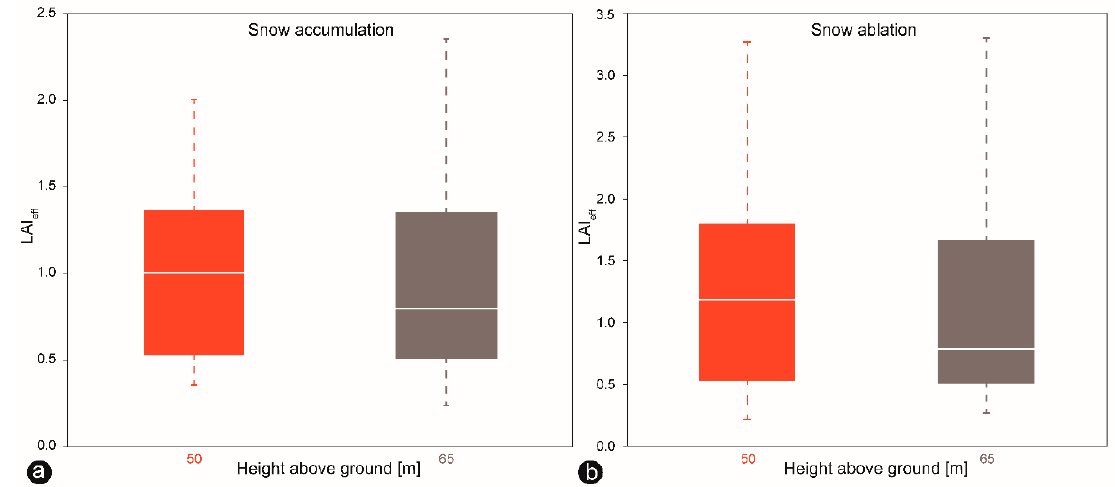
Figure 13. (a) Results of the UAV-based LAI eff estimates. On the y -axes, the effective LAI is marked, and the flight altitude is plotted on the x -axis. The boxes identify the middle 50%, the median, and the maximum standard deviations for LAI points of UAV-based measurements at 50 m and 65 m altitude during snow accumulation. (b) Results of the UAV-based LAI eff estimates at 50 m and 65 m altitude during snowmelt.